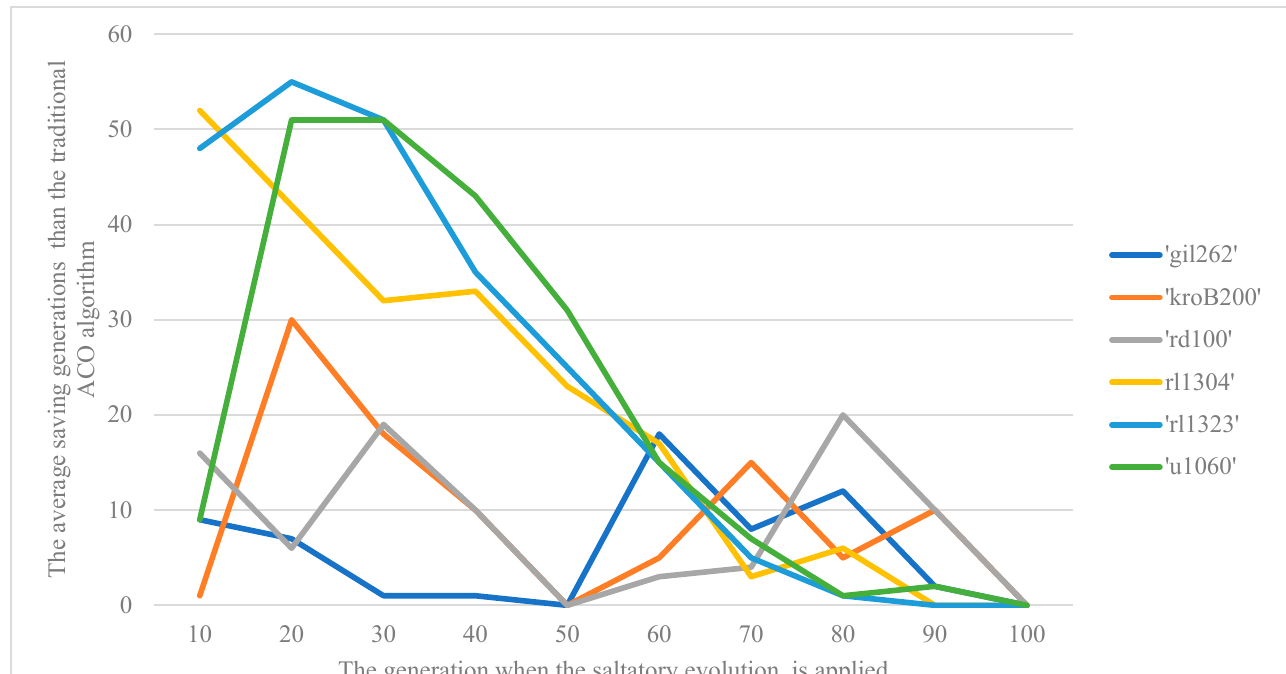
Figure 4. The saving generations of SEACO algorithm on test data sets. As shown in Table 4, the optimization rate of the SEACO algorithm on the test data sets is over 46% before 90th generation, and over 80% before 40th generation. This indi- cates that the SEACO algorithm has wide applicability and effectiveness on approximat- ing TSPs with limited time window. Moreover, it can be seen from Figure 4 that the earlier the SEACO algorithm is conducted, the faster the optimization speed is improved. Specif- ically, the SEACO algorithm performs best at the 20th generation with 100% optimization rate, and 52 generations can be saved at most, and 27 generations can be saved on average. However, the performance of the SEACO algorithm has not been improved at the 100th generation, which indicates that the SEACO algorithm is more suitable to be injected into